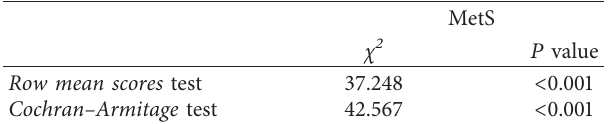
Table 4: Row mean scores and Cochran–Armitage trend tests of the impact of asprosin on